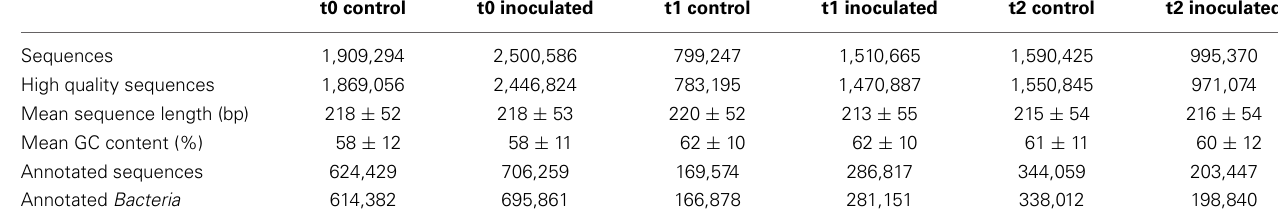
Table 1 | Statistics of metagenome sequencing of DNA preparations from the rhizosphere of Lactuca sativa treated with B. amyloliquefaciens FZB42 ( + FZB42) and corresponding controls.